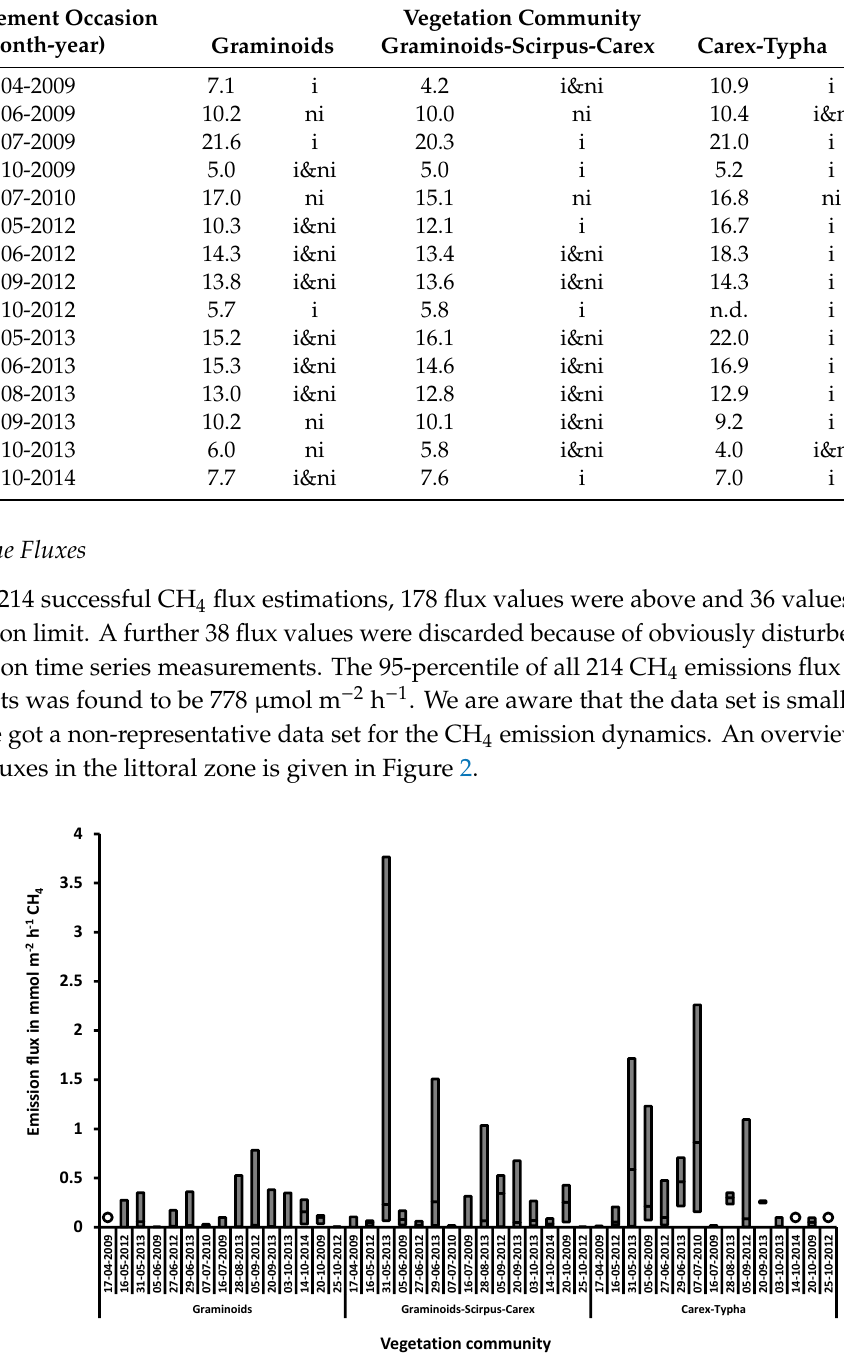
Figure 2. Methane emission fluxes in the littoral zone on measurement occasions. Bars: minimum, median and maximum; circle: no data.